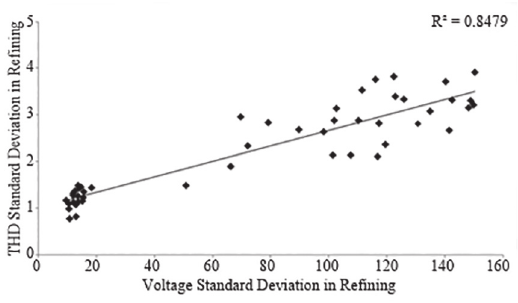
and THD standard deviation was performed, according to Figure 10. Heats with FeO content between 27.5 and 35%, basicity between 2.6 to 3.2 were used.